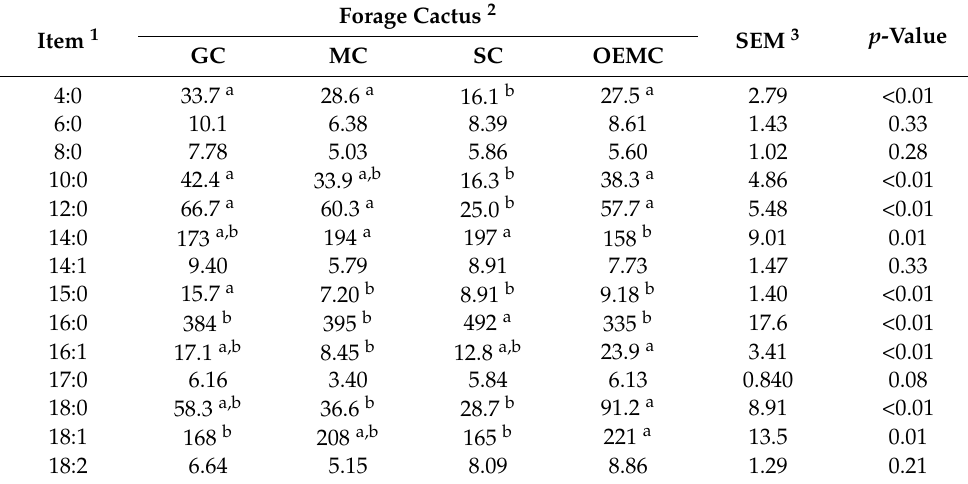
Table 6. Effects of forage cactus genotypes on milk fatty acid profile (g/kg of fatty acids; n = 8). Forage Cactus 2 Item 1